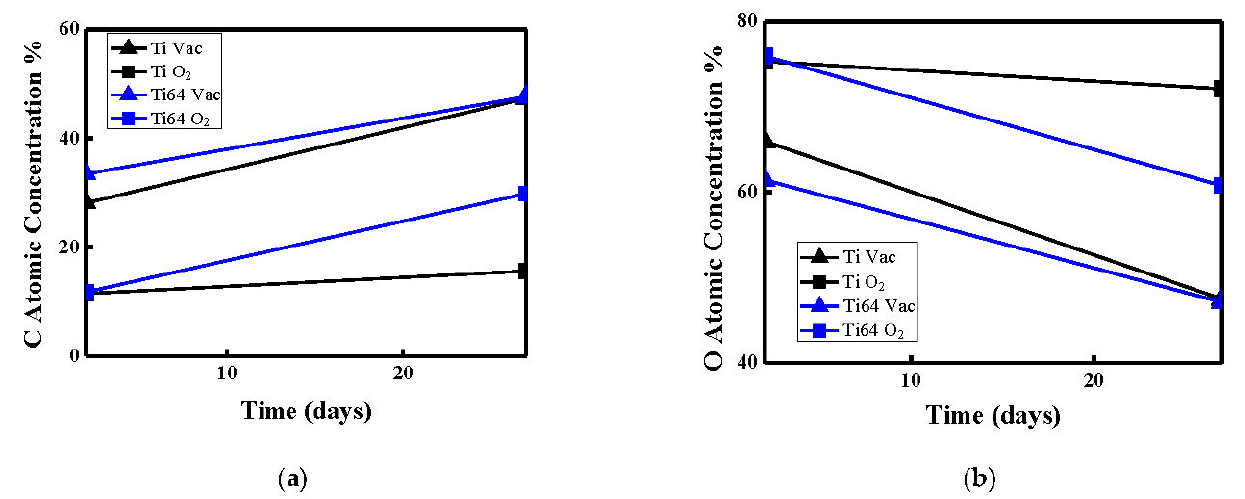
Figure 12. The variations in the concentration of chemical elements in the laser-modified surface with different holding times during different atmospheres in the N0 samples of CP-Ti and Ti64 for ( a ) the carbon content and ( b ) the oxygen